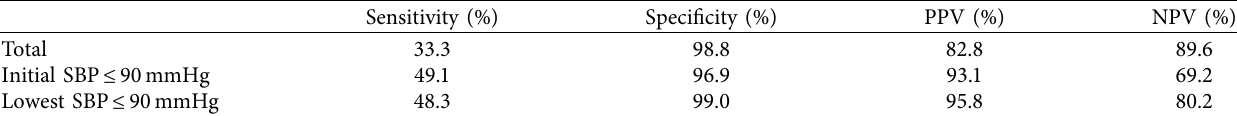
Figure 1: Study population. Table 1: Accuracy of FAST examination according to